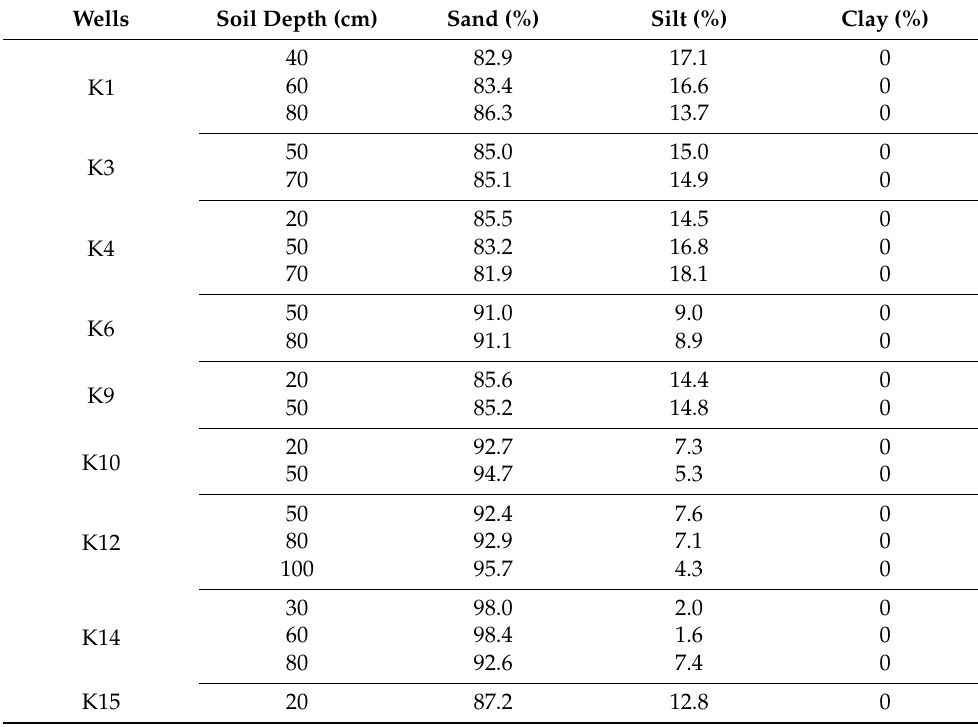
Meteorological data (i.e., solar radiation, air temperature, air humidity, and